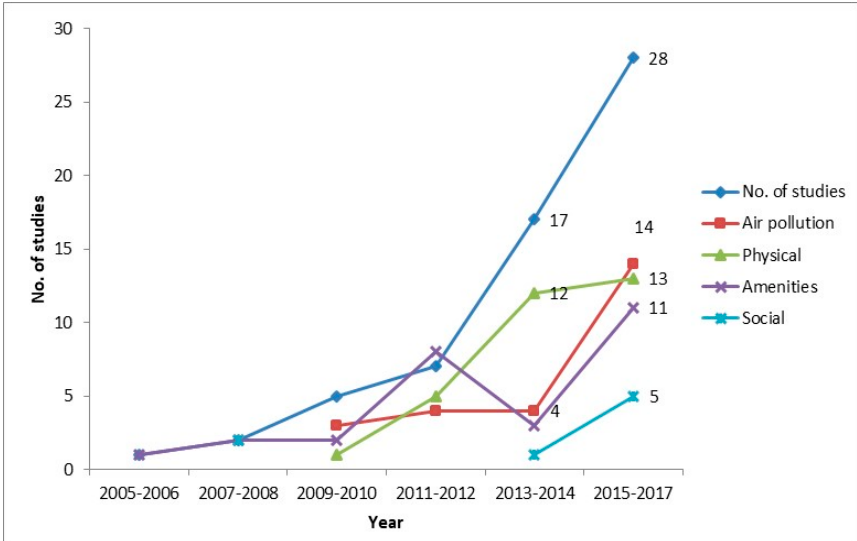
Figure 3. Number of studies and environmental characteristics studied by year. Physical includes roadways proximity, walkability, open space, green space, tree canopy, traffic, noise, urban sprawling, and slope; Amenities includes food and physical activity environment, recreational facilities, transport system, and health service; Social includes safety, violence, crime, physical disorder, area and housing conditions, and infrastructure.